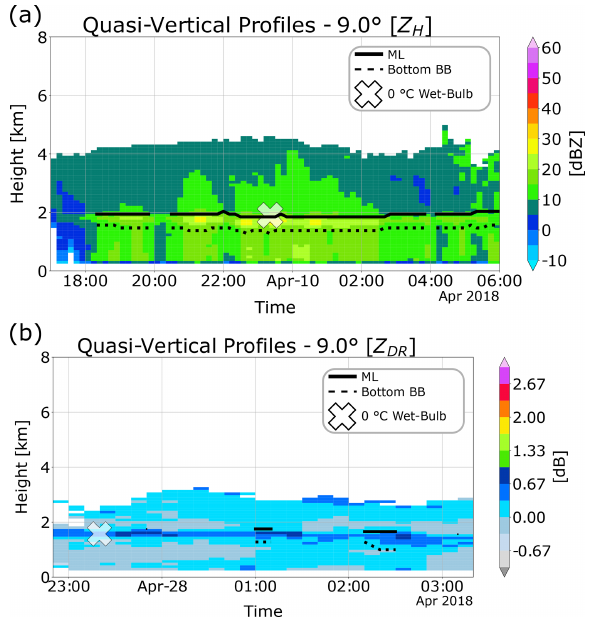
Figure 13. Comparison of the MLA outputs based on the variable P 10 for QVPs constructed from 9 ◦ elevation angle scans. Panel (a) shows the detection of the melting layer for a stratiform event dis- played over a height versus time plot of Z H ; panel (b) shows the performance for a convective event displayed over a height versus time plot of Z DR